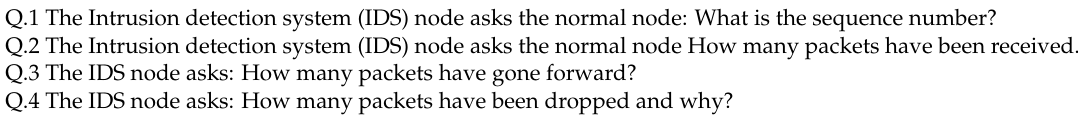
Table 2. Intrusion detection system (IDS) analysis through questions in status